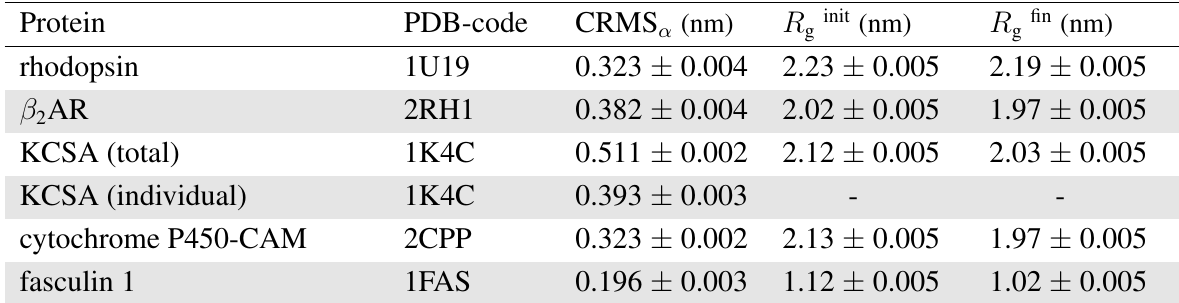
Table 1. Analysis results for five different protein CG MD simulations. Both the CRMS and R (for the initial and final conformations) are given. All numbers are an average over g 240 ps of simulation time. For the KCSA potassium channel the results are given for the total complex as well as for an average of the separate